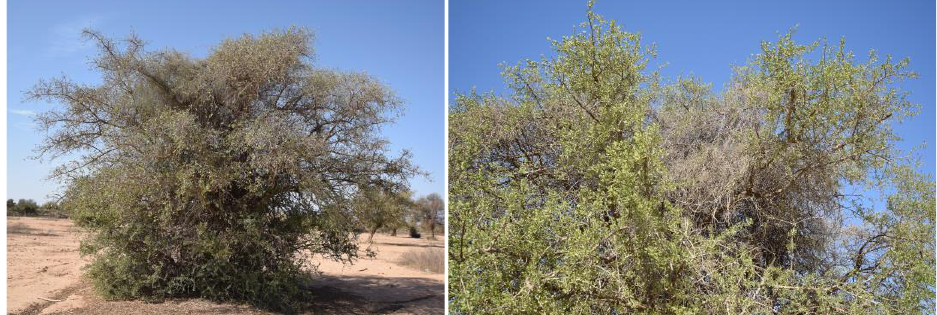
Figure 1. Argania spinosa associated with the liana Ephedra altissima .